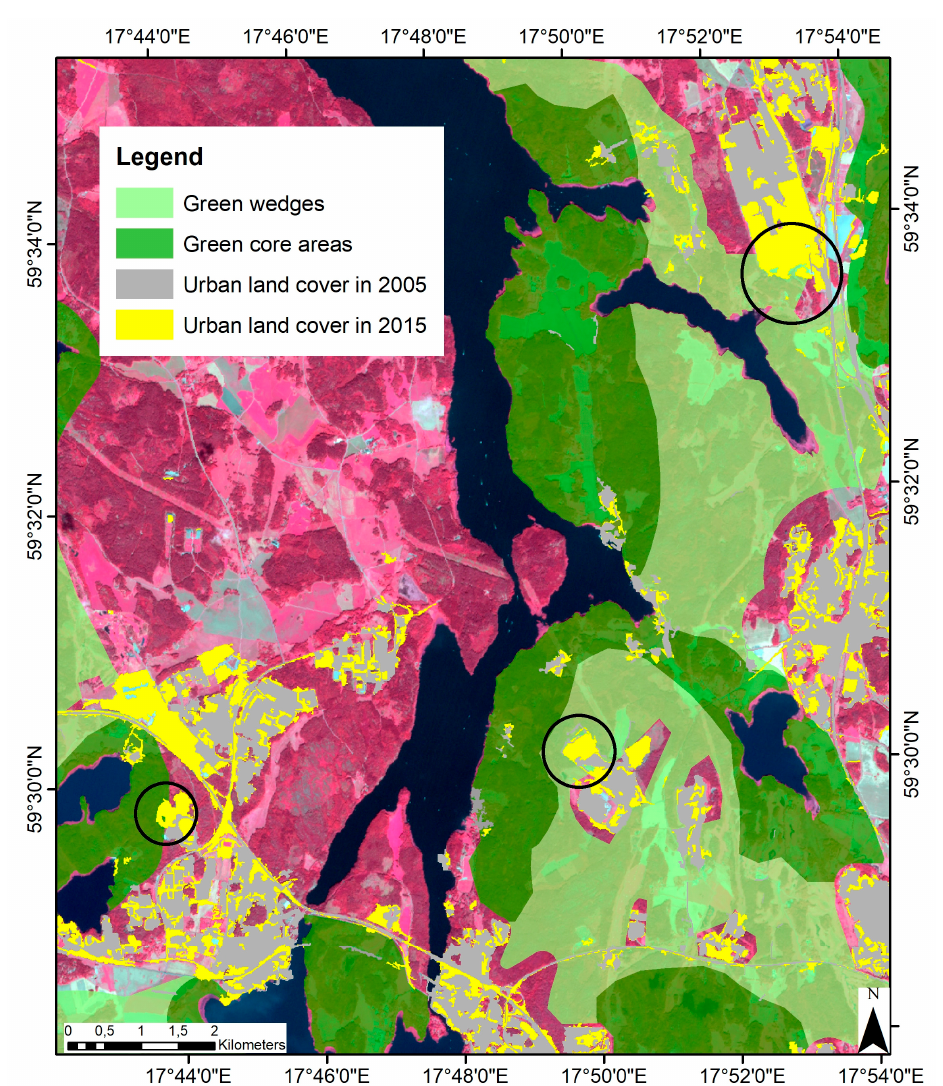
Figure 12. Examples of urban expansion and overlap with parts of the Görväln and Järva green wedges and core areas in Sigtuna, Upplands-Bro and Upplands-Väsby Municipalities between 2005 and